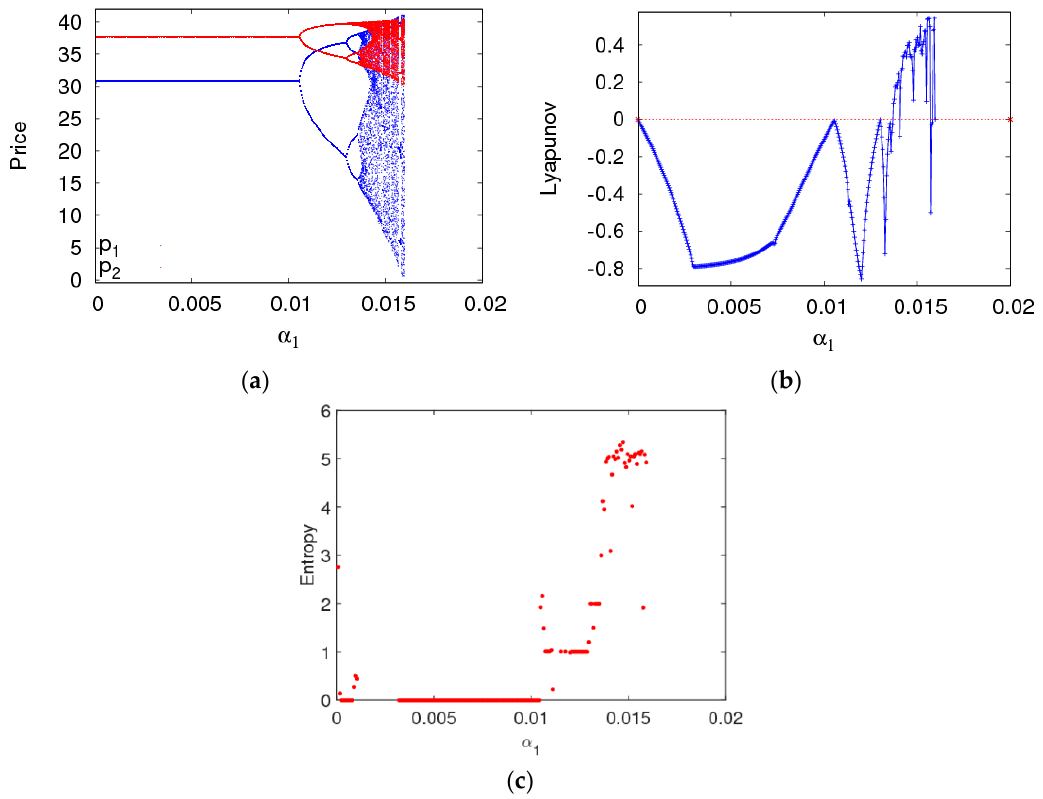
Figure 5. The behavior of dynamic system (6) with respect to α 1 when α 2 = 0.008. ( a ) The bifurcation diagram, ( b ) The LLE diagram, ( c ) The entropy diagram.